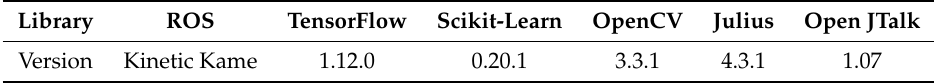
Table 2. Versions of software